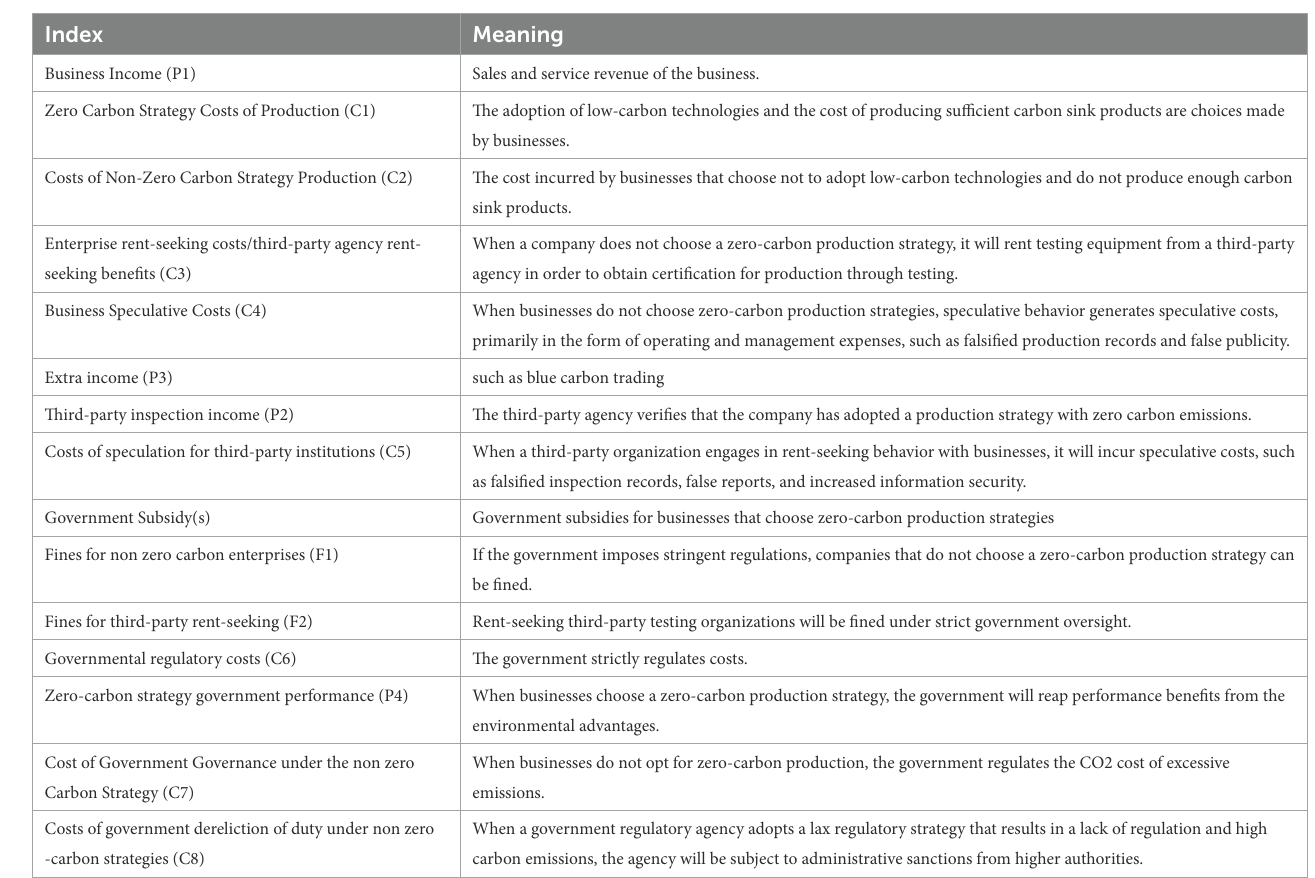
TABLE 1 Research assumptions and parameter settings.